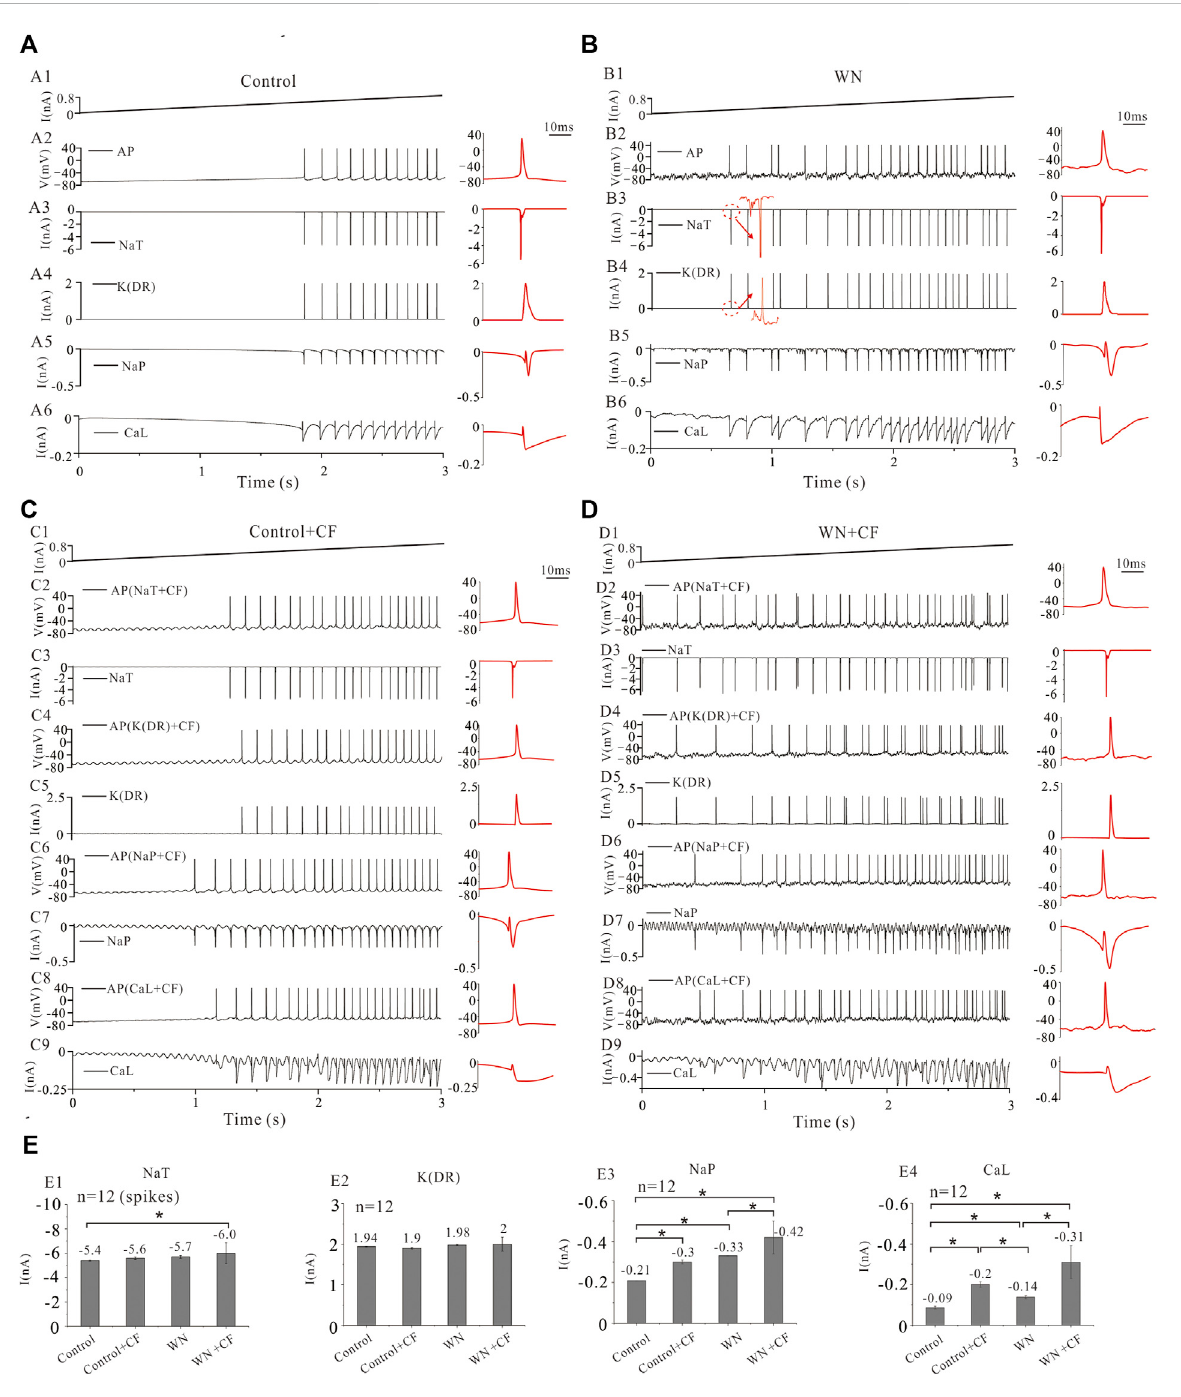
FIGURE 8 Ionic currents with white noise and channel fl icker (CF). (A) : Repetitive fi rings and corresponding currents of NaT, K(DR), NaP, and CaL induced by injection of a ramp current with a duration of 3 s and a peak of 0.8 nA. The red traces in the right insets were action potentials (AP) averaged from the fi rst 12 spikes with averaged corresponding currents. (B) Tonic fi rings were evoked by the same ramp current with white noise. The averaged AP (red)andaveragedcorrespondingcurrentsofNaT,K(DR),NaP,andCaLwereshownintherightinsets(redtraces).Morespikeswereevokedand larger inward currents were induced by WN. (C) The channel fl icker (CF) was added to NaT, K(DR), NaP, and CaL, respectively. Repetitive fi ring was induced by a current ramp (C1) and the fi rst 12 spikes were averaged from the fi rings recorded with NaT + CF (C2,C3) , K(DR)+CF (C4&C5) , NaP + CF (C6&C7) and CaL + CF (C8&C9) , respectively. The averaged spikes and averaged ionic currents were shown in the right insets (red traces). More spikes were generated and bigger inward currents were induced by CF. (D) The channel fl icker (CF) was added to NaT, K(DR), NaP, and